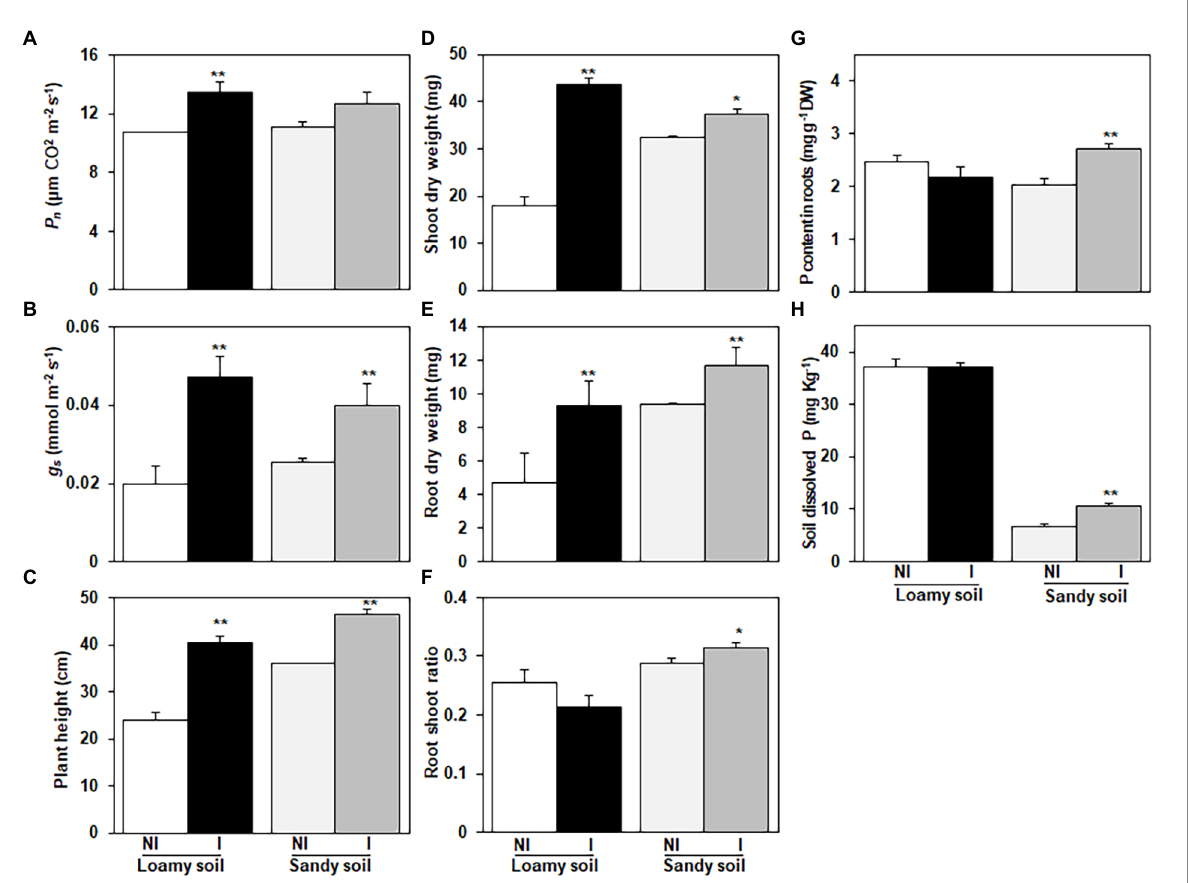
FIGURE 4 Effects of Enterobacter cloacae NG-33 strain inoculation on leaf net photosynthetic rate ( P n ); (A) and stomatal conductance ( G s ); (B) , plant height (C) , shoot dry weight (D) , root dry weight (E) , root shoot ratio (F) , P content in roots of maize seedlings (Zh58) (G) and soil dissolved P content after harvest (H) . Data are the mean and ± SE of four replicates for inoculated (I) and non-inoculated (NI) plants under loamy soil (subtropical) and sandy soil (phosphorus-deficient) with supplemental application of tricalcium phosphate. The difference between the means is significant at p < 0.05 (*) and p < 0.01 (**) level.